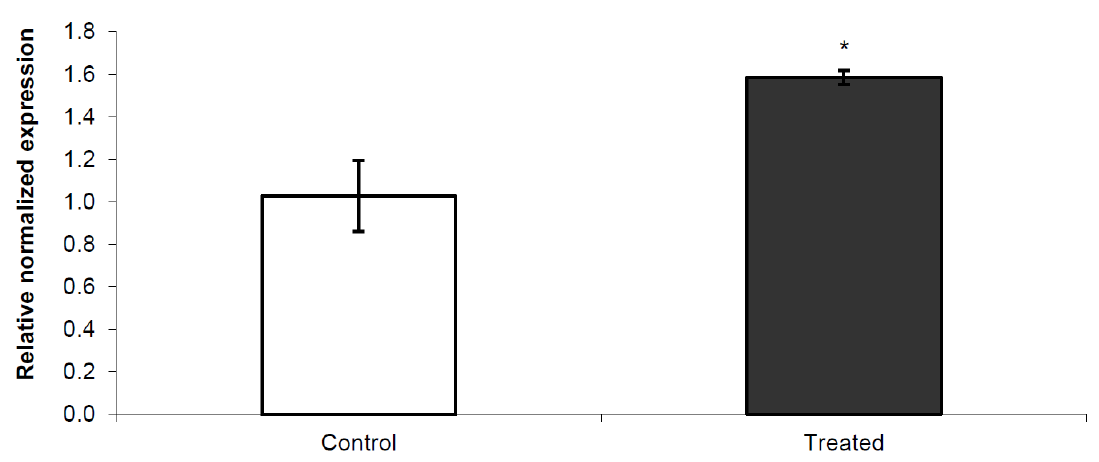
Figure 1. qPCR to quantify relative changes in Nurr1 expression in striatum of young rats exposed to permethrin treatment in early life. All expression values were normalized to the value of β-actin gene used as an internal control. * p < 0.05 vs.